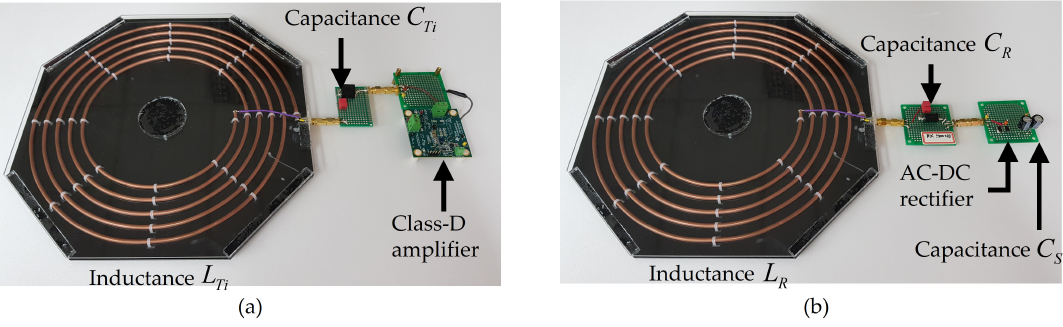
Figure 7. Implementation based on Figure 6: ( a ) transmitter and ( b ) receiver.